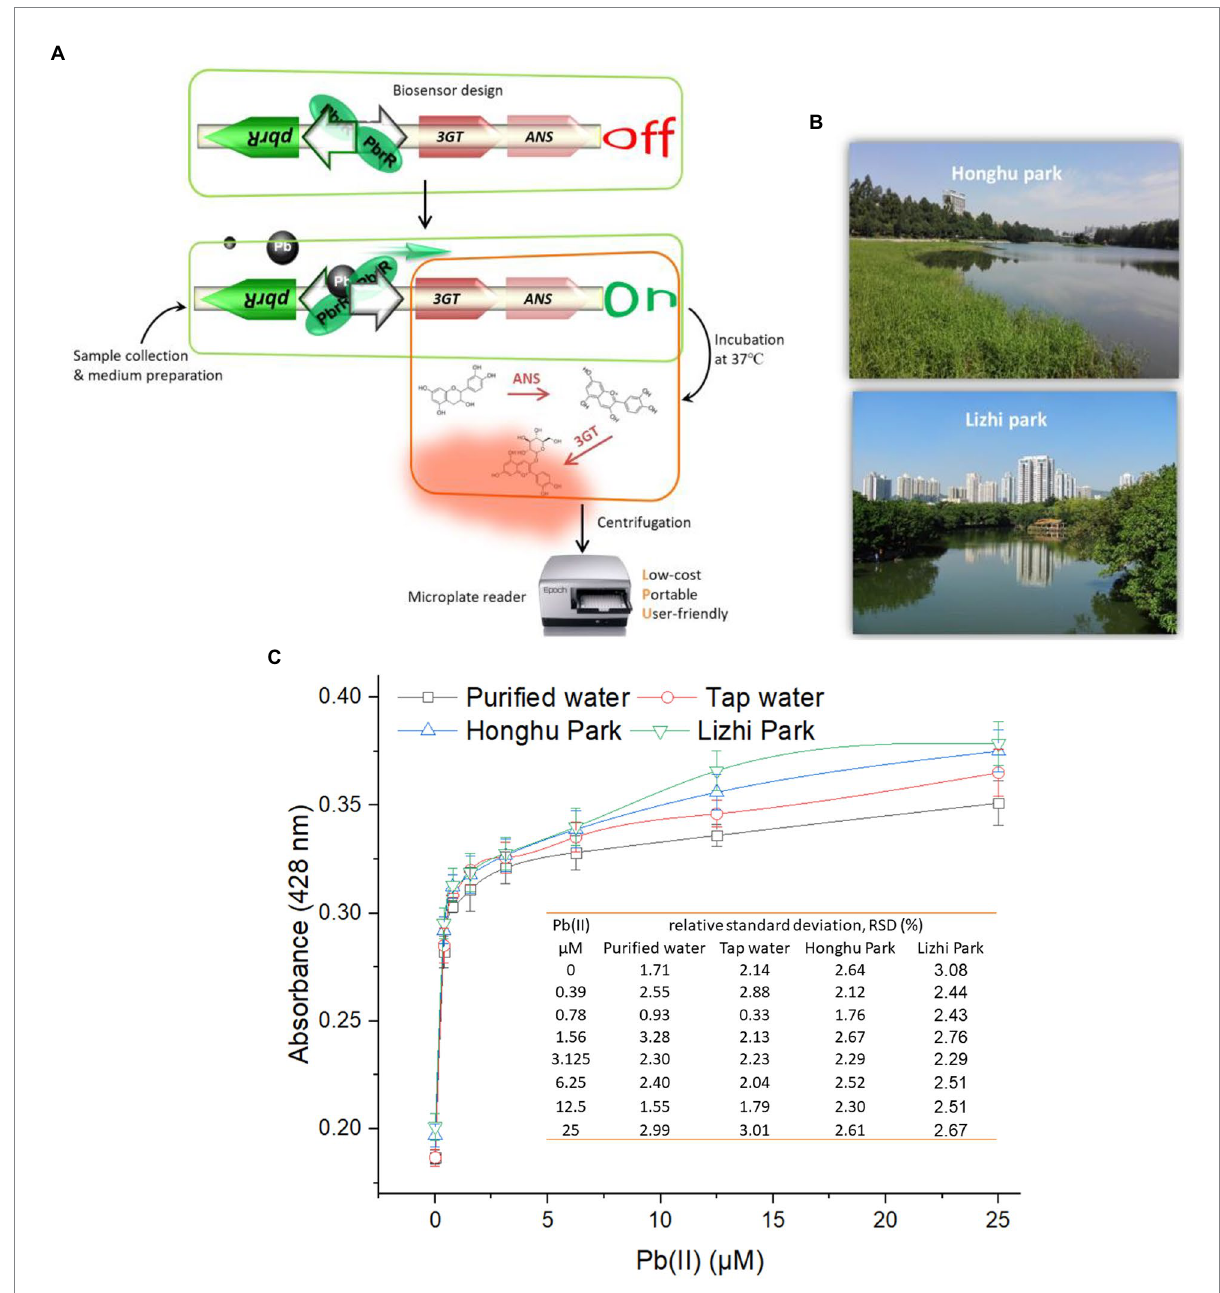
FIGURE 5 Detection of bioavailable Pb(II) in environmental samples using TOP10/pPb-CACD. (A) The detailed protocol for the field measurement. The capability of TOP10/pPb-CACD was validated in determining bioaccessible Pb(II) in environmental samples using a three-step colorimetric method. Surface water was collected from two downtown parks in Shenzhen city, South China (B) . TOP10/pPb-CACD was inoculated into fresh LB medium prepared with four different water samples and supplemented with 1 mM catechin. Different concentrations of Pb(II) were spiked into the culture system. After culturing at 37 ° C overnight, the cell-free culture supernatants containing CACD were prepared and determined at 428 nm (C) . Data shown are mean ± SD ( n = 3). The inset table shows the relative standard deviation (RSD) of pigment derived